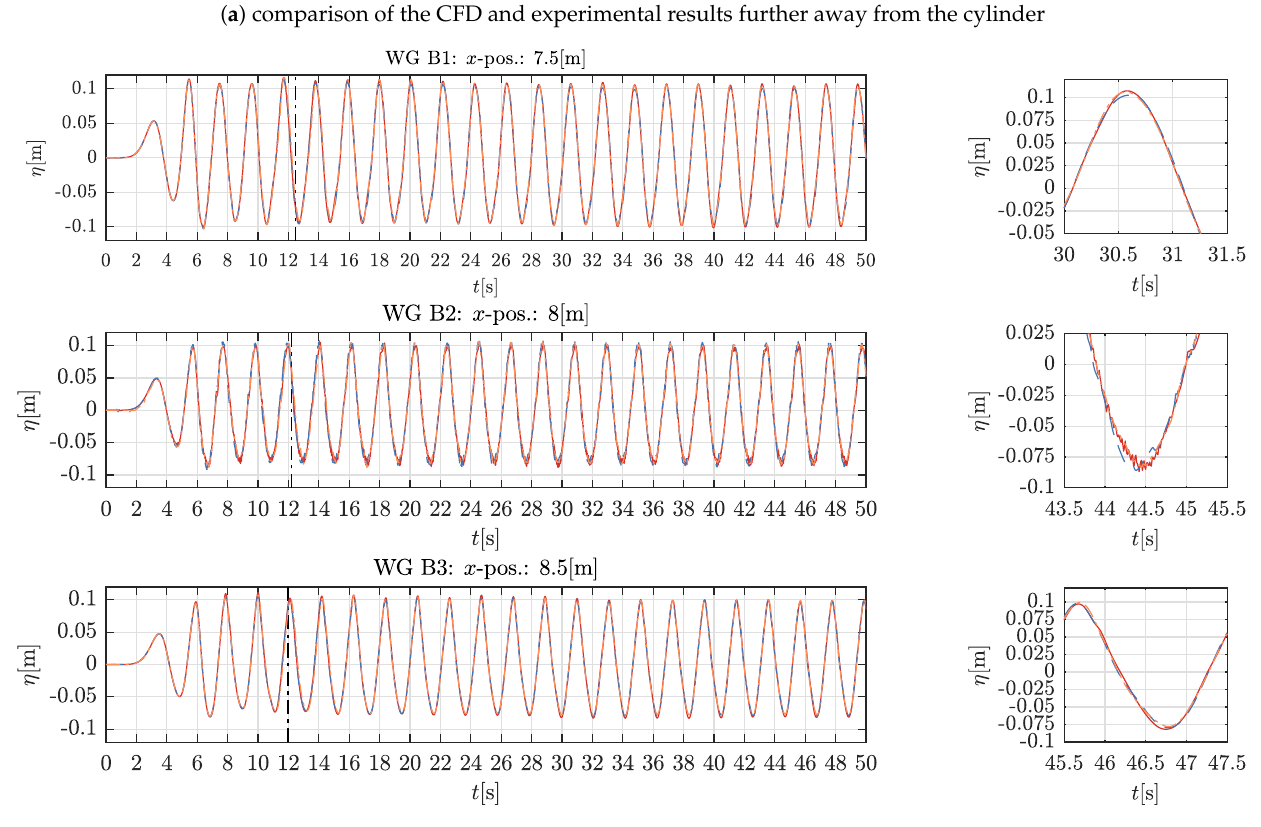
Figure 9. Experimental and CFD results of the wave elevation, η ( t ) , at selected WGs close to the porous cylinder for all types of porosity implementation, including the whole time series and selected close-ups. ( a ) comparison of the CFD and experimental results further away from the cylinder ( b ) comparison of the CFD results close to the cylinder (no experimental WG results